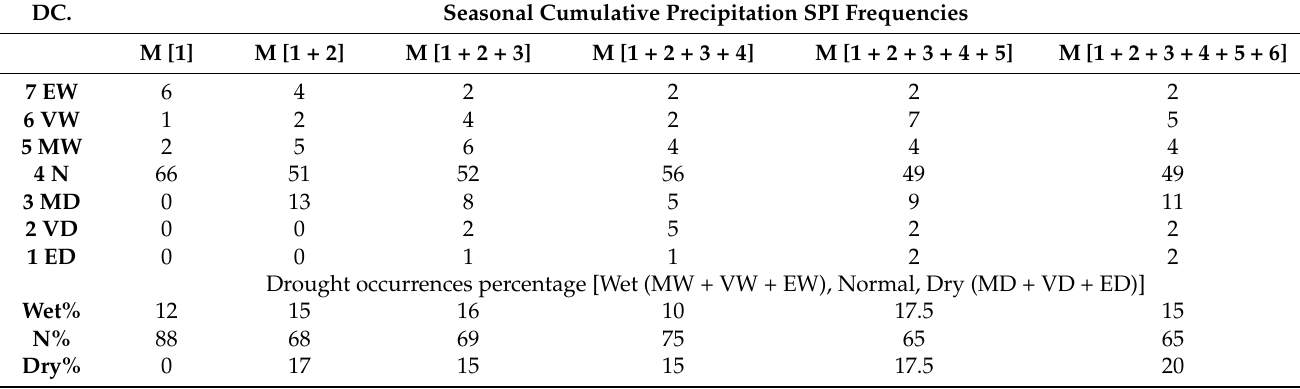
* represents the three PNI wet classes (EW, VW, and MW). Table 5. Monthly cumulative precipitations SPI drought